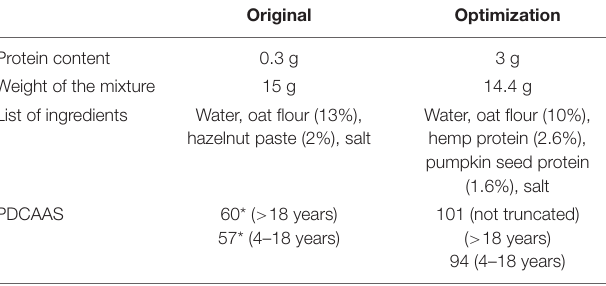
TABLE 5 | Comparison of optimized formula versus original product.